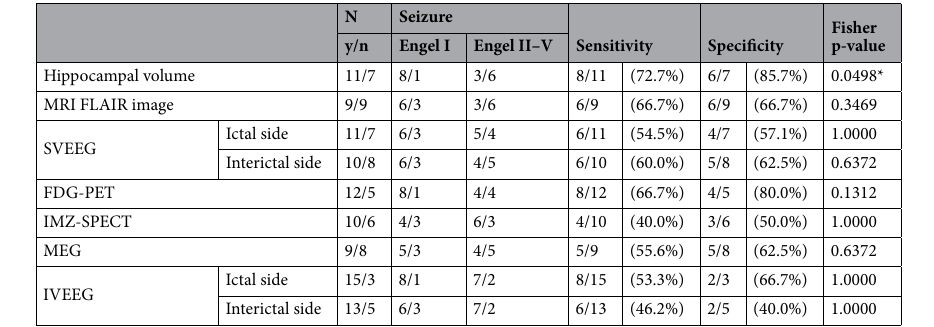
Table 4. Analysis of data. SVEEG, scalp video electroencephalogram; FDG-PET, fluorodeoxyglucose- position emission tomography; IMZ-SPECT, iomazenil single photon emission computed tomography; MEG, magnetoencephalography; IVEEG, intracranial video